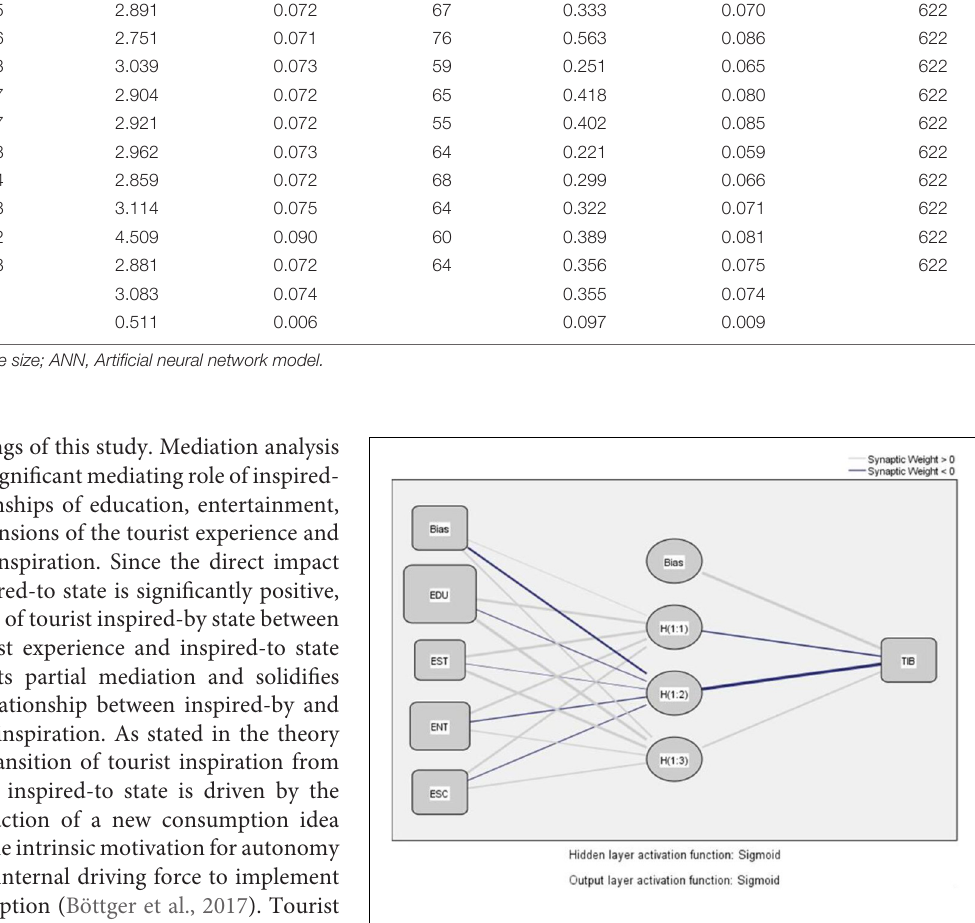
FIGURE 3 | Artificial neural network